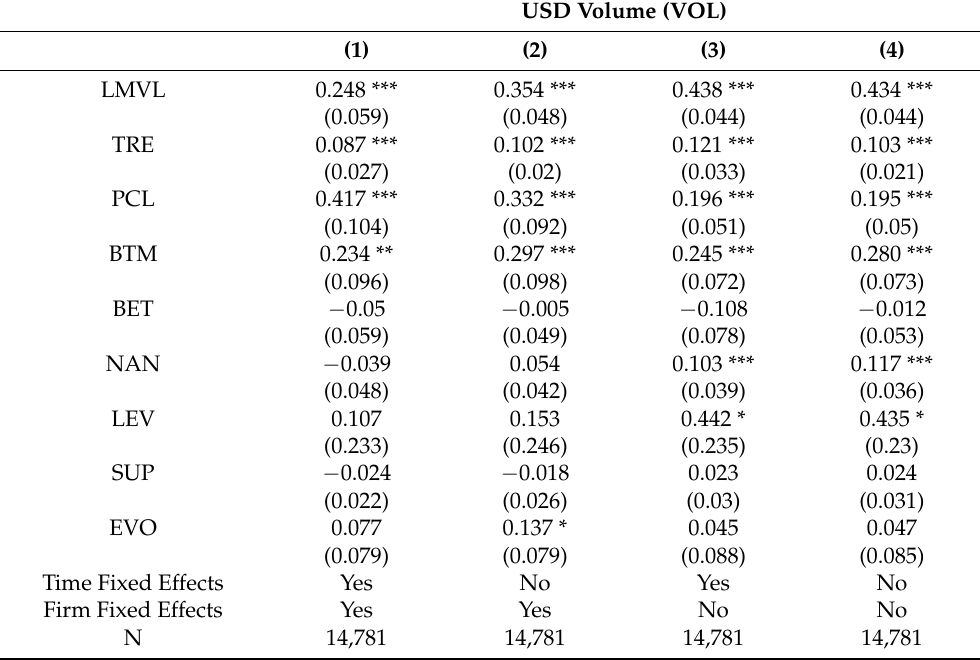
Table 2. Panel regression results USD volume. The table contains estimated regression coefficients from equation (1) and the associated standard errors in parentheses. The standard errors are double clustered around both time and firms. ***, **, and * denote statistical significance at the 1%, 5%, and 10% levels, respectively. N is the number of observations. The yes and no in the rows labeled with Time Fixed Effects and Firm Fixed Effects indicate whether a certain type of fixed effects was